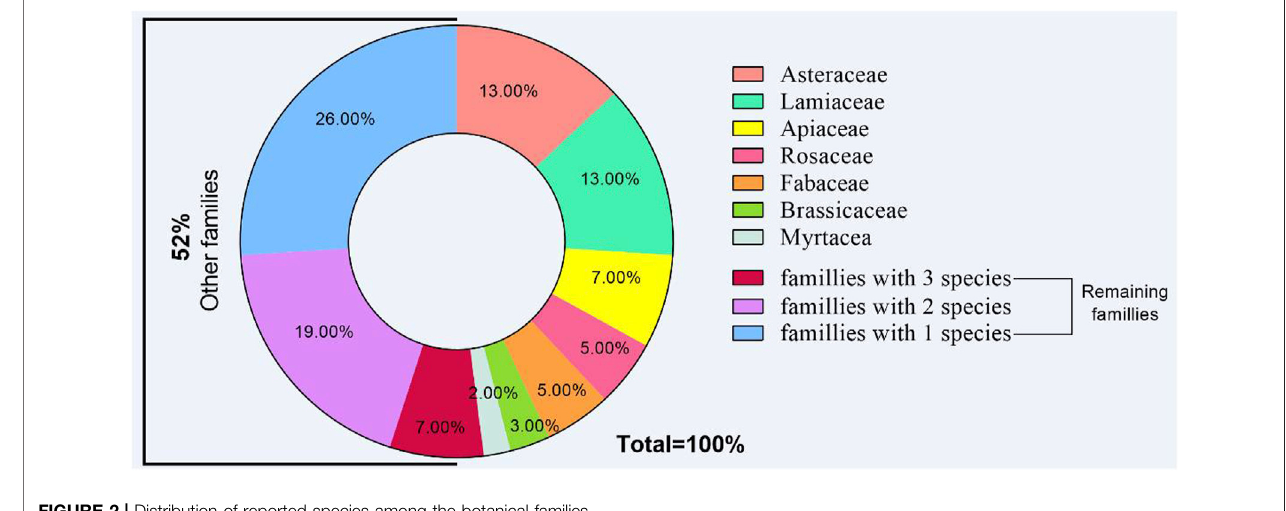
FIGURE 2 | Distribution of reported species among the botanical families.